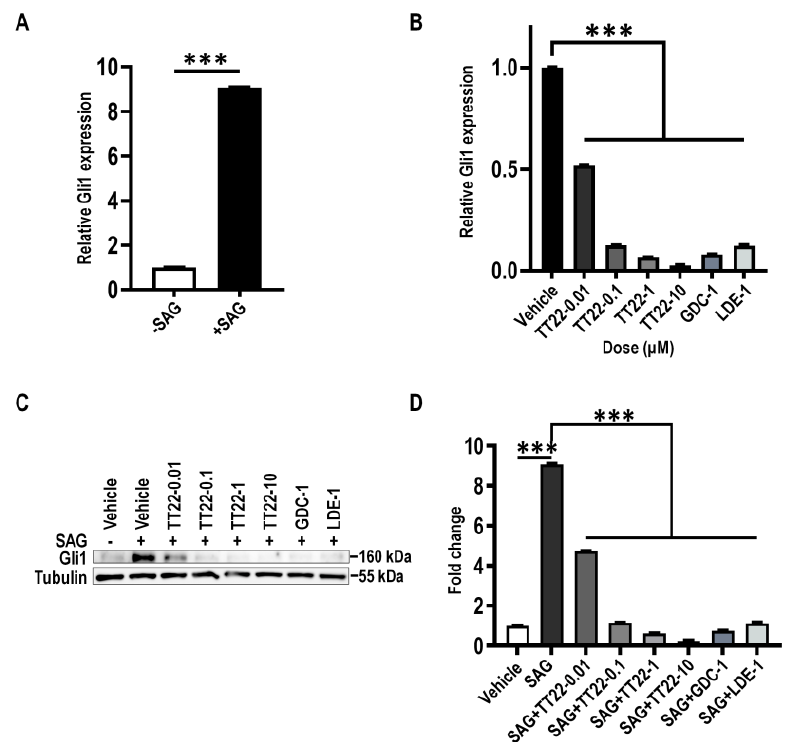
Figure 8. The expression of Gli1 stimulated with SAG was suppressed by TT22. ( A ) Serum-starved NIH3T3 cells were treated with 100 nM SAG for 24 h, then analyzed for mRNA levels of Gli1. ( B , C ) Serum-starved NIH3T3 cells were induced by 10 − 7 M (100 nM) SAG with DMSO (vehicle), with the indicated concentration of TT22, 1 µ M LDE-225 (LDE-1) or 1 µ M GDC-0449 (GDC-1) for 24 h. Cells were analyzed for mRNA levels ( B ) and the protein levels ( C ) of Gli1. ( D ) Quantitation of Gli1 protein levels normalized to Tubulin loading control measured the dose-dependent inhibition of the Hh pathway activity by TT22 upon SAG stimulation. All data are means ± SEM (Student’s t -test and one-way ANOVA). *** p <